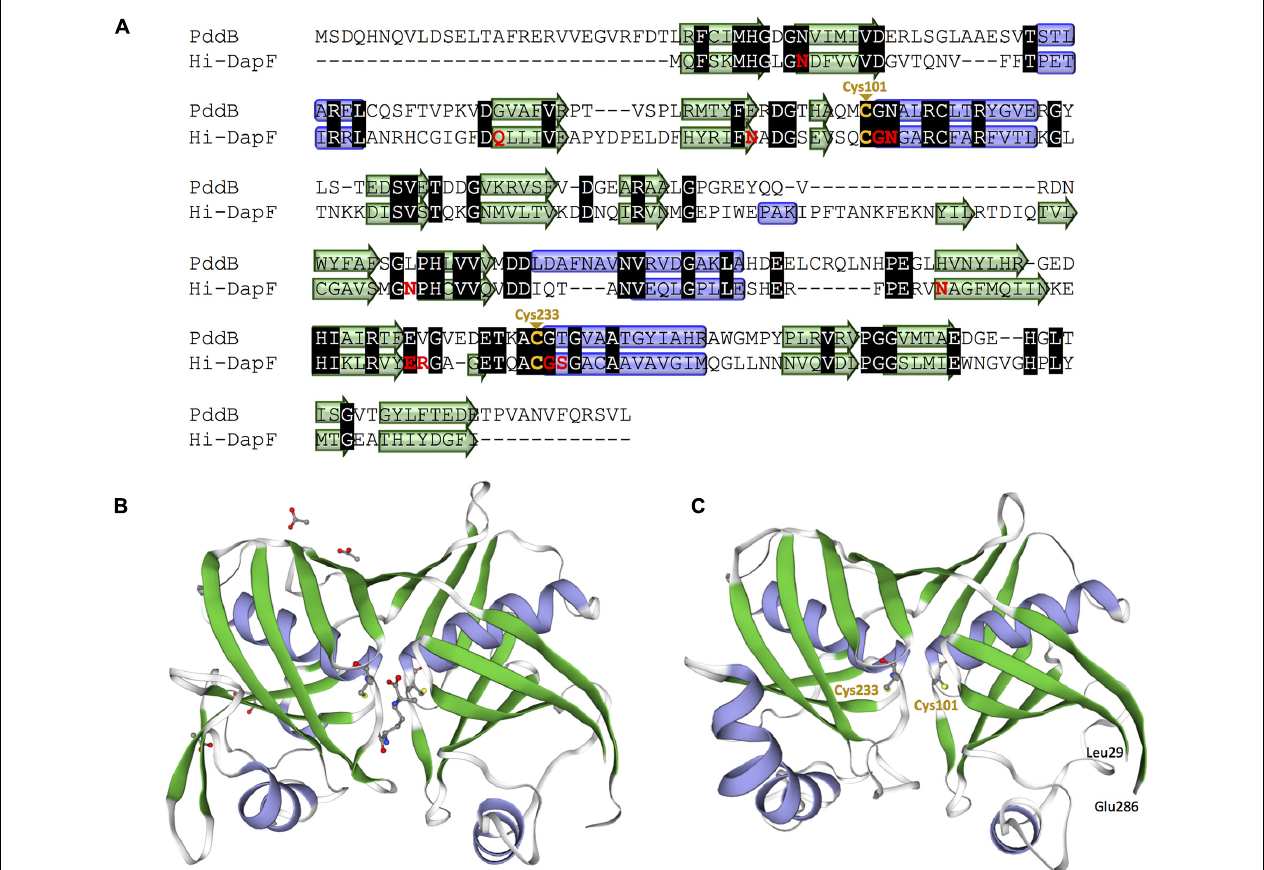
FIGURE 4 | Amino acid sequence and structural models of PddB. (A) Amino acid sequence alignment of PddB and DapF from Haemophilus influenzae (Hi-DapF) with their secondary structural comparison. Helices and sheets predicted by the Dictionary of Secondary Structure of Proteins (DSSP) algorithm are marked as blue tubes and green arrows, respectively. In the Hi-DapF sequence, amino acid residues which have been reported to interact with the substrate via hydrogen bonds or a salt bridge are highlighted in red. (B) 3D structure of Hi-DapF in complex with an irreversible inhibitor LL -AziDAP (PDB ID: 2GKE). (C) 3D structural model of PddB. The model was built in the SWISS-MODEL server using the structure of Hi-DapF as a